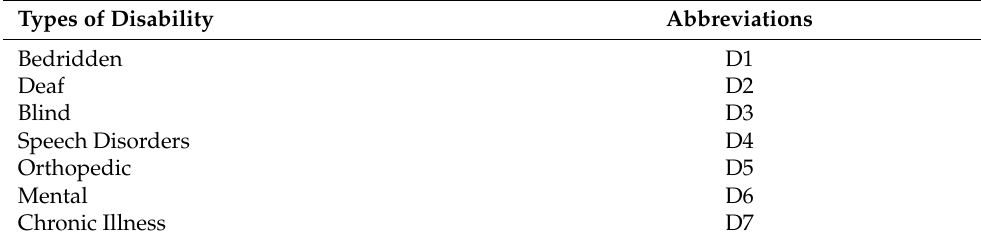
Table A2. The disability status of the patients who request home health services.